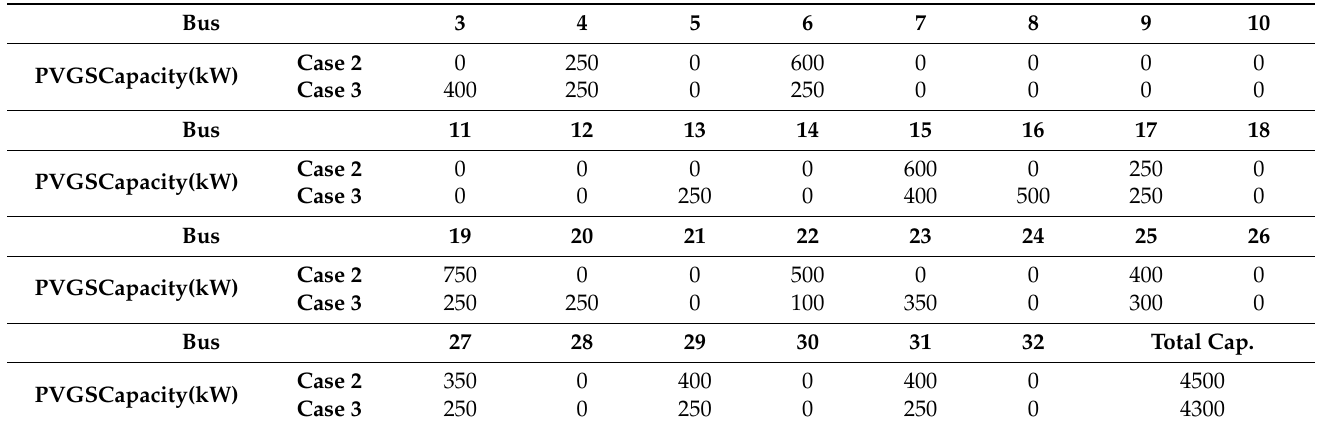
Table 1. The optimal solution for PVGS sizing and the location of Case 2 and Case